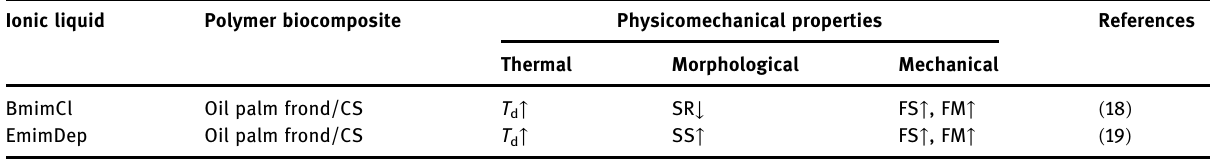
Table 4: Physicomechanical properties of polymer biocomposites pretreated with chloride - and diethyl phosphate - based ionic liquids Ionic liquid